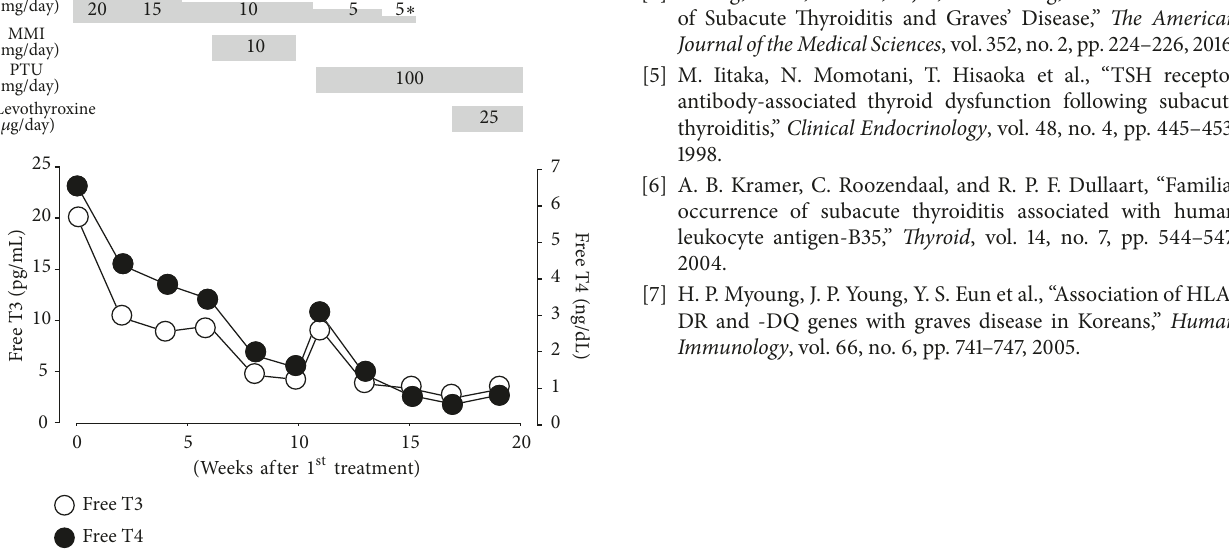
Figure2:Changesinserumthyroidlevelsduringtheclinicalcourse. 5∗ , 5 mg every 2 days; PSL, prednisolone; MMI, methimazole;